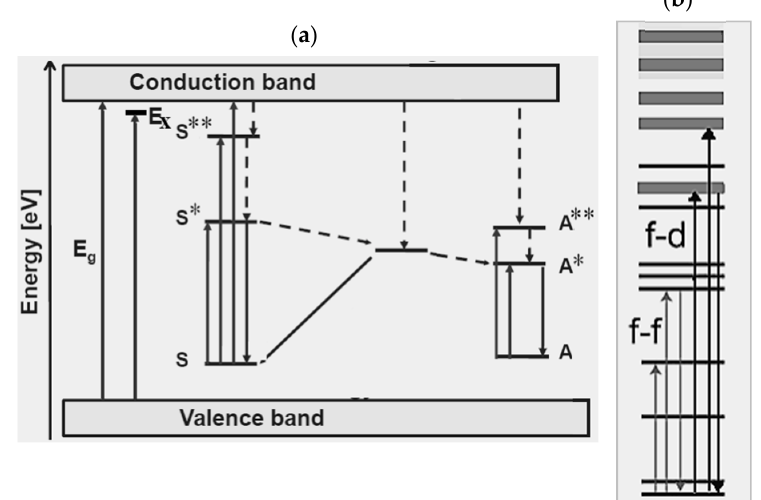
Figure 5. Characteristic luminescent processes occurring in a rare earth (RE)-doped host crystal. ( a ) Shows band-to-band absorption through the gap with energy gap Eg, generation of an exciton with energy Ex, absorption, luminescence and energy transfer processes related to sensitizer (S)-activator (A) pairs. The continuous and dashed lines refer to radiative and non-radiative transitions, respectively. The asterisk indicates excited states. ( b ) Sketches processes where an electron is excited from the lanthanide’s occupied 4f orbitals to its unoccupied 4f or 5d orbitals. The shaded upper region is the conduction band.